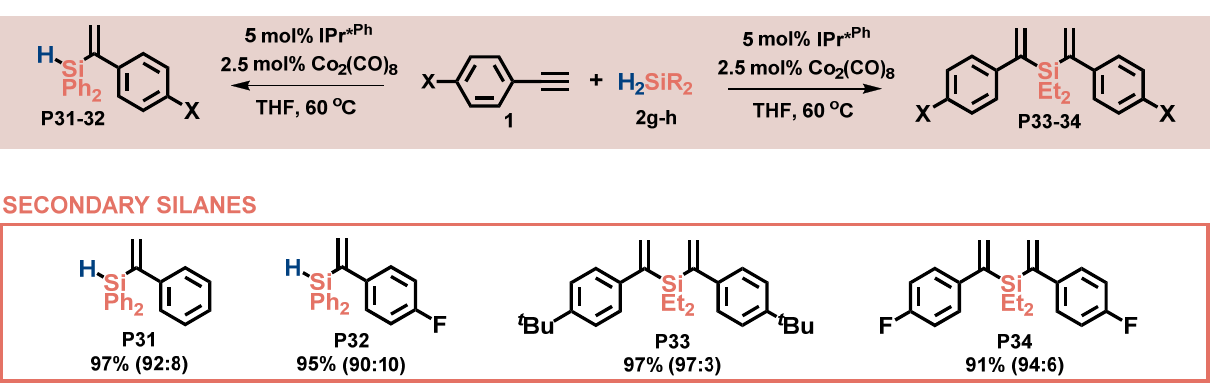
7 of 12 Figure 4. Substrate scope—tertiary silanes. Reaction conditions: argon, THF, 60 °C, 5 h, [ 1a ]:[ 2b-f ] =